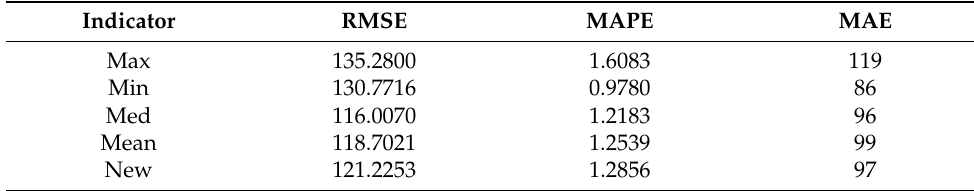
Table 3. BGA 11.5X13 1st indicator